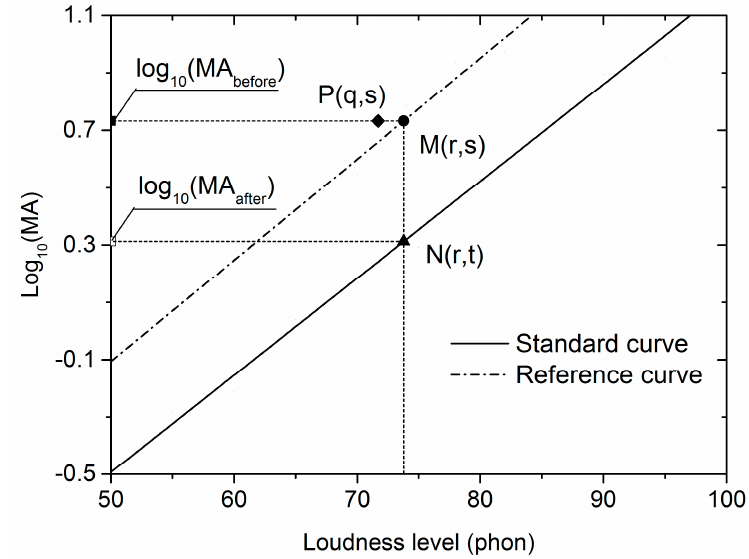
Figure 1. Illustration of calibration procedure of a demonstration sample (point P, shown as ◆ in the figure) for mean annoyance (MA).